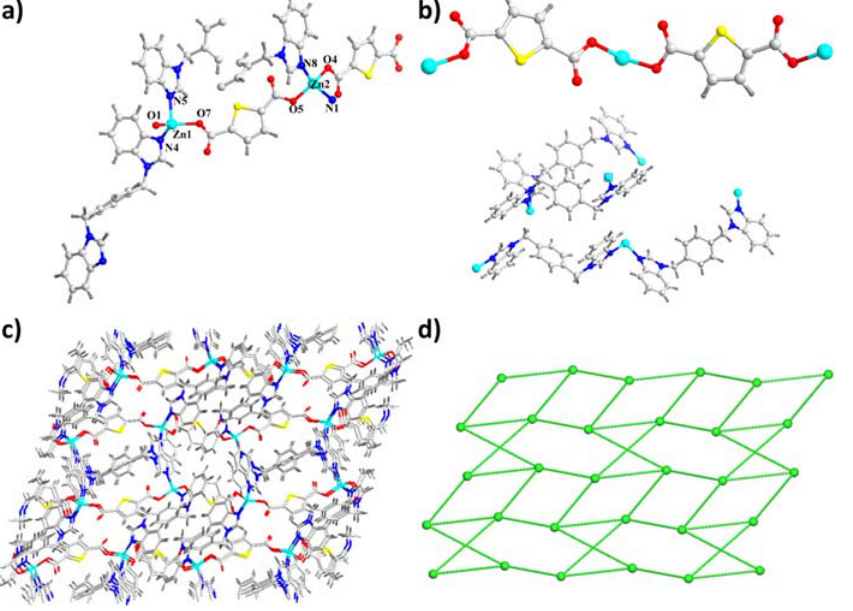
Figure 2: ( a ) View for an asymmetric unit for complex 2 . ( b ) These two ligands ’ coordination modes. ( c ) 2 ’ s three - dimensional skeleton. ( d ) The sra topology for complex 2